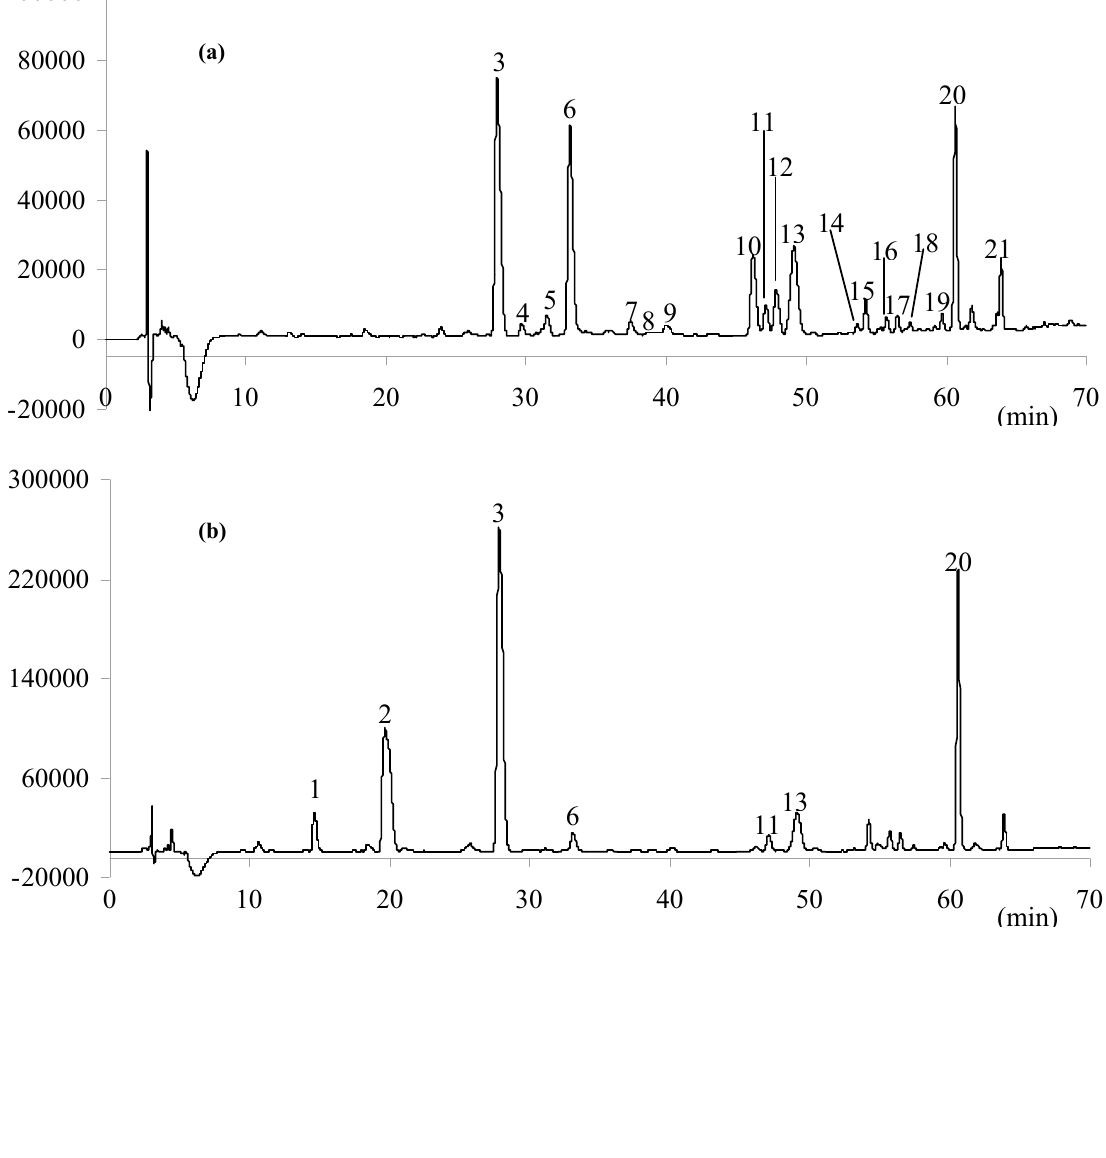
Figure 1. HPLC chromatograms of Lonicera japonica flos (LJF) samples collected in Shandong province for the qualitative analysis. ( a ) Sun-dried; ( b ) Sulfur-fumigated. The peak number refers to the compound number shown in Table